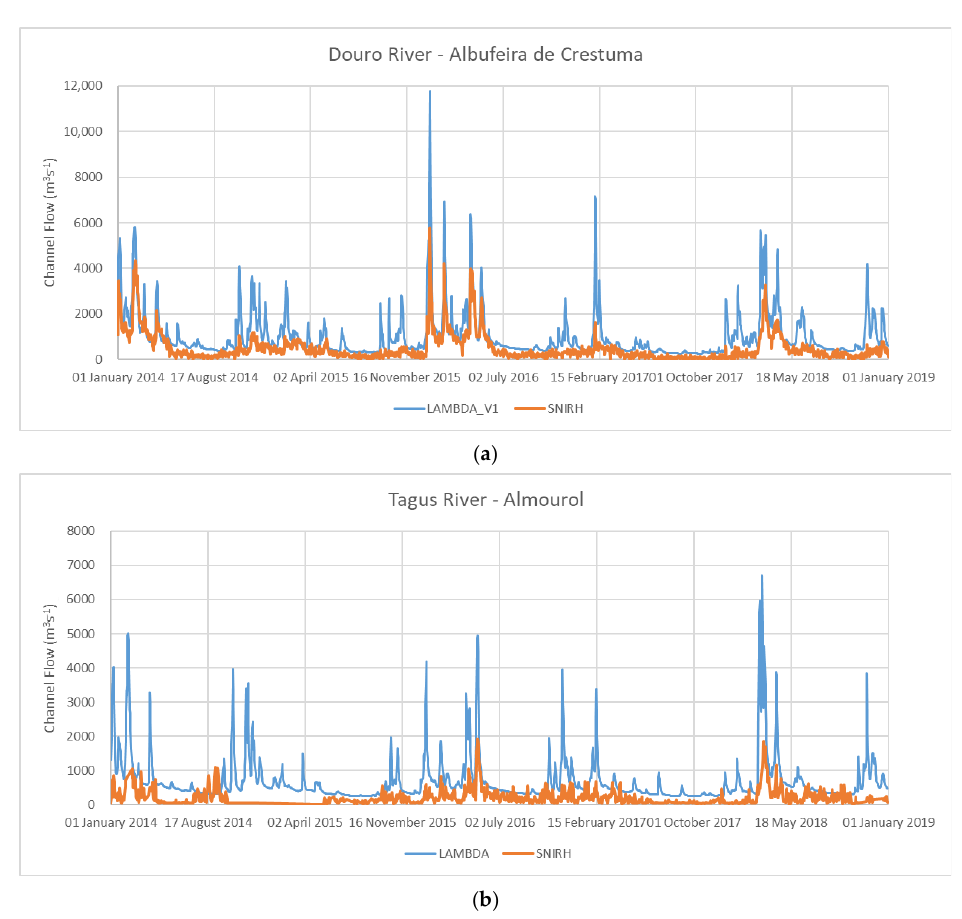
Figure 5. Observed (orange line) and modelled (blue line) river flow for the period 2014–2018 used for validation in ( a ) Douro River at Albufeira de Crestuma station; ( b ) Tagus River at Almourol station (Source for observed data: Portuguese Environmental Agency